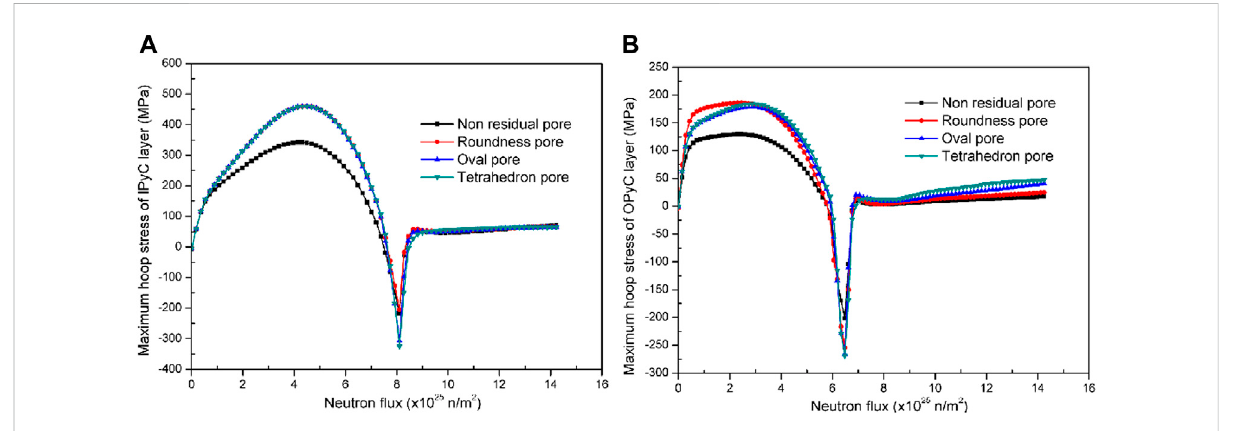
Hoop stress curves of the IPyC and OPyC layers with neutron fl